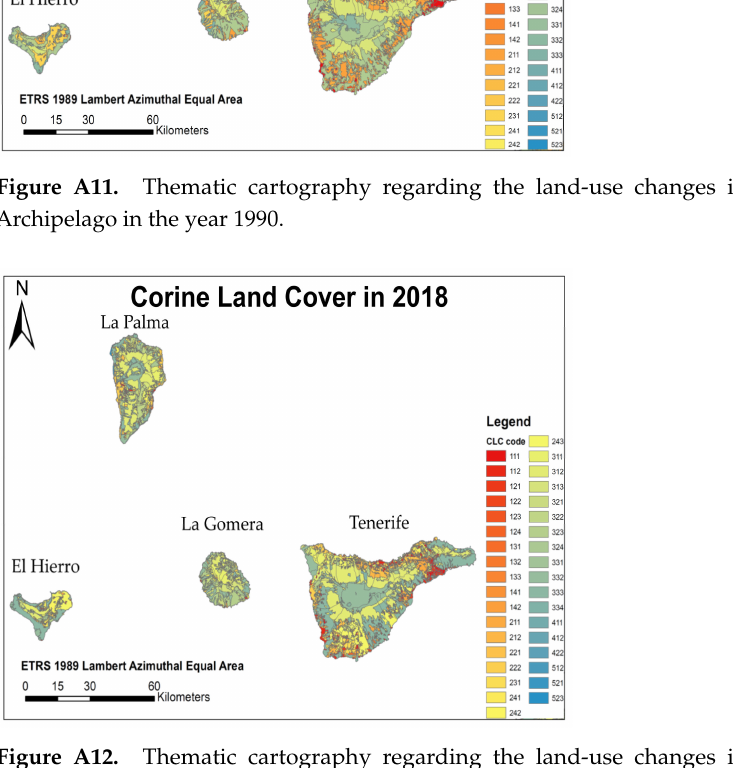
Figure A12. Thematic cartography regarding the land-use changes in the South of Canary Archipelago in the year